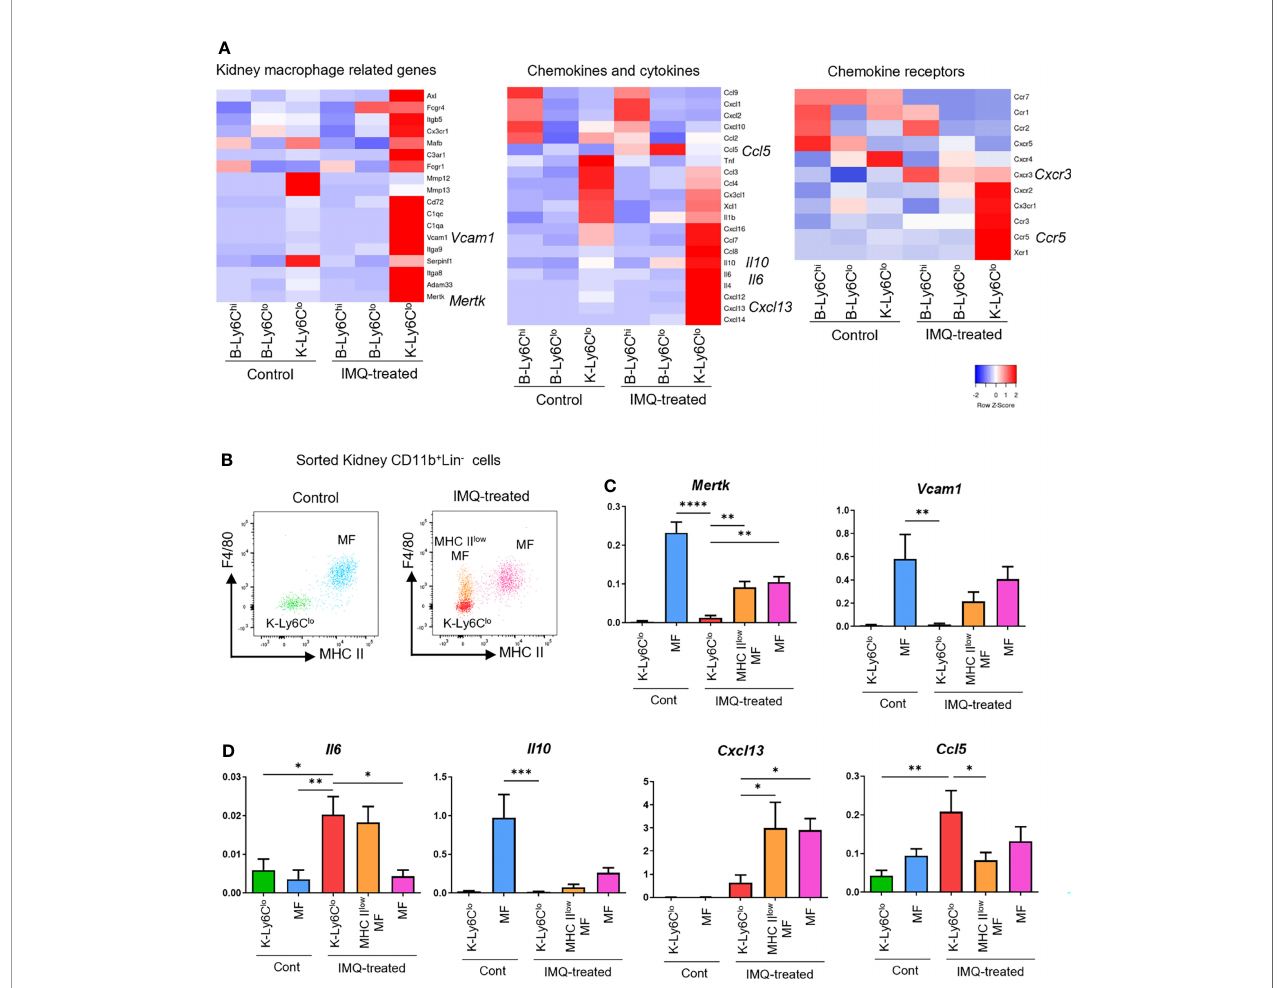
FIGURE 5 | Gene expression features of monocytes, monocyte-like cells, and MF in IMQ-induced lupus mice. (A) RNA-seq analysis of blood monocytes and kidney monocyte-like cells in the controls and IMQ-treated mice. (B) Plot of sorted monocyte-like cells and MF from control and IMQ-treated mice. Each cell type was sorted from kidney CD11b + Lin - cells as follows. K-Ly6C lo = F4/80 - MHCII lo Ly6C lo CX3CR1 + cells; MHC II low MF = MHC II lo F4/80 + cells; MF = MHC II hi F4/80 + cells. (C, D) qRT-PCR analysis of sorted kidney cells from control and IMQ-treated mice. RNA-seq and qRT-PCR results are of pooled samples from four groups of mice each analyzed individually (16 control or 5 IMQ-treated mice were used for each pooled sample in the RNA-seq analysis. Ten control or 3 IMQ-treated mice were used for each pooled sample in the qRT-PCR analysis). In the qRT-PCR analysis, the y-axis shows the fold change expression in comparison with the expression of Gapdh . Bar and horizontal lines indicate the mean and SEM. *P < 0.05, **P < 0.01, ***P < 0.001, and ****P < 0.0001 by one way ANOVA and post hoc Dunnett ’ s multiple comparison test. B-Ly6C hi , blood Ly6C hi monocytes; B-Ly6C lo , blood Ly6C lo monocytes; K-Ly6C lo , kidney Ly6C lo monocyte-like cells. MHC II low MF, MHC II lo macrophage-like cells; MF,